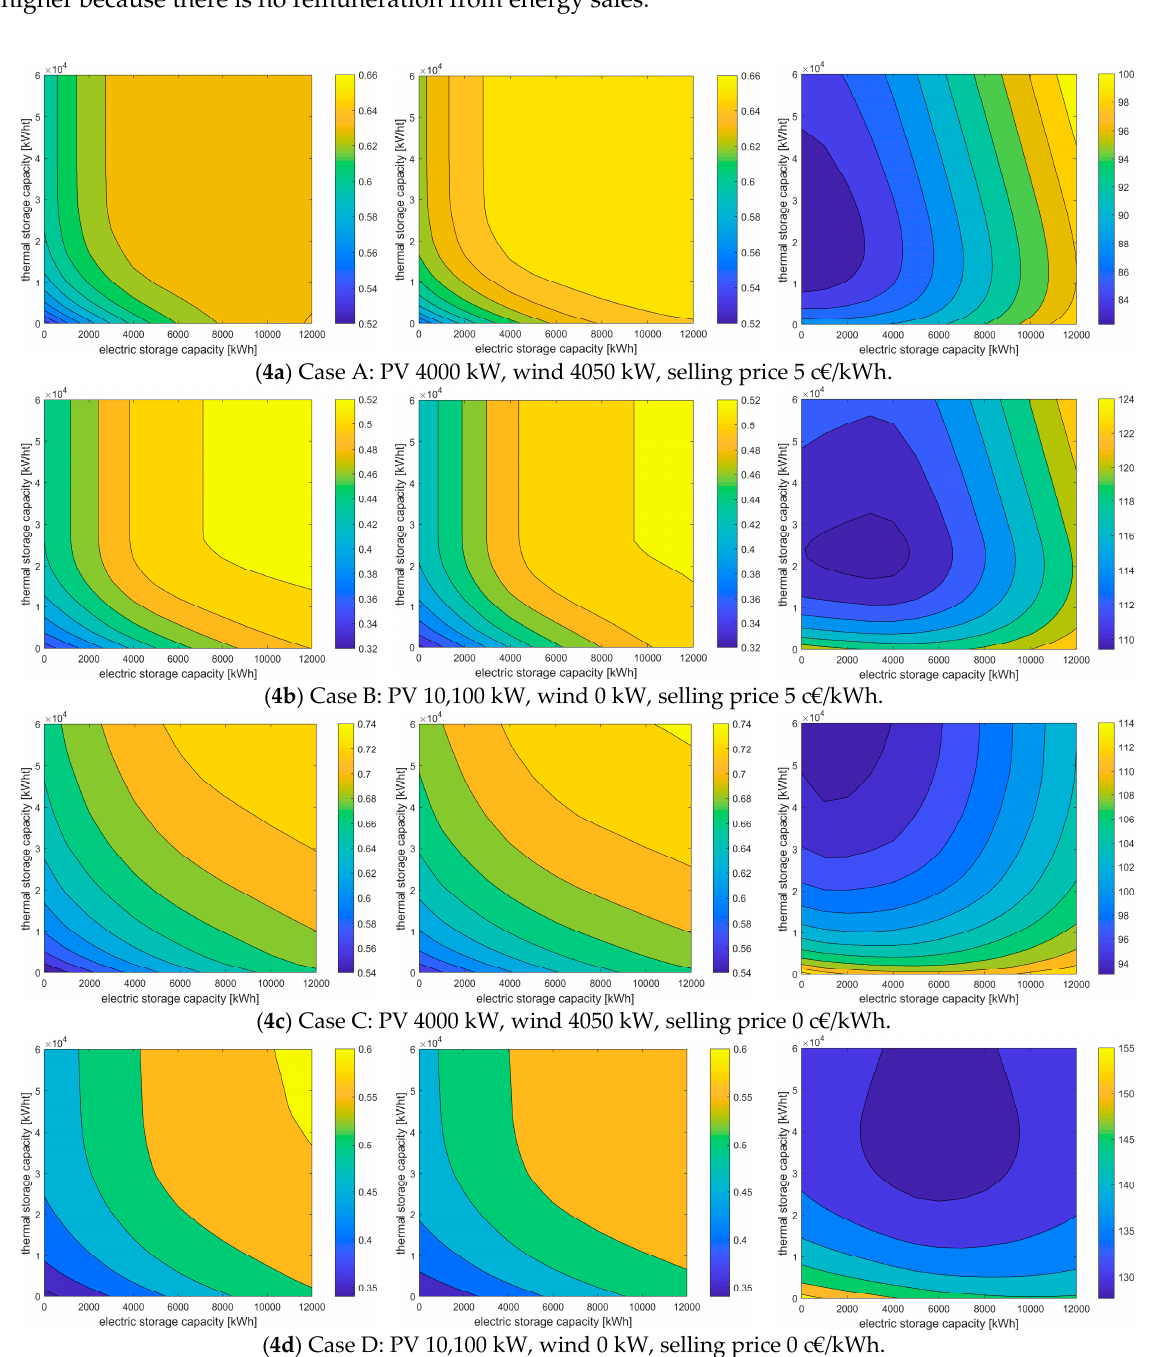
Figure 4. Test results for all test cases. System self-consumption index ( SSCI ), left ; system Figure4. Testresultsforalltestcases. Systemself-consumptionindex( SSCI ), left ; systemself-su ffi ciency self-sufficiency index ( SSSI ), center ; levelized cost of energy ( LCOE ) in €/MWh, right . index ( SSSI ), center ; levelized cost of energy ( LCOE ) in € / MWh, right